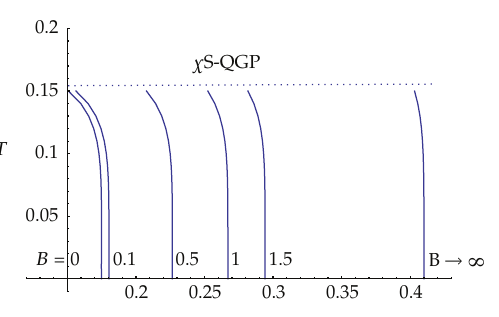
Figure 17: The onset chemical potential of the multiquark- ∇ ϕ phase as a function of T, B (cid:3) for B → ∞ , u (cid:8) 1 . 23 is used (cid:4) . These lines can be served as the transition lines between the ∇ ϕ phase on the 0 left and multiquark- ∇ ϕ phase (cid:3) n s (cid:8) 0 (cid:4) on the right. The dotted line represents schematic transition to the chiral-symmetric QGP